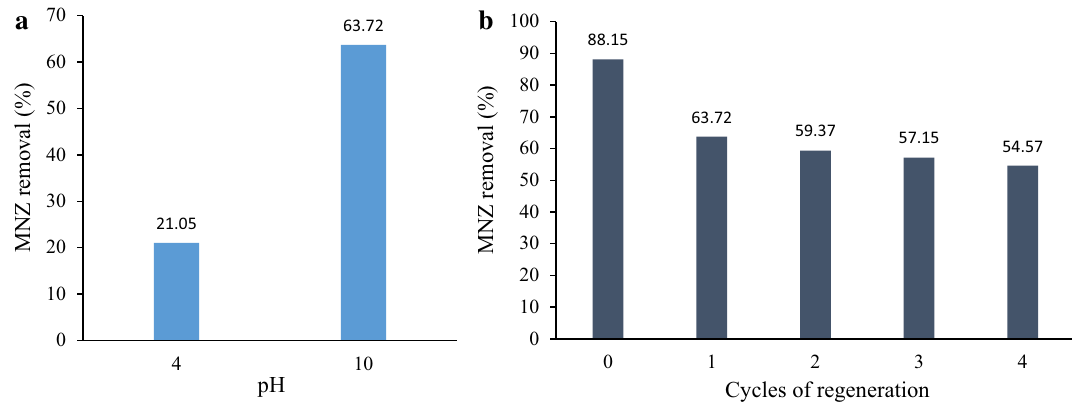
Fig. 6 Biomass reusability; MNZ removal efficiency for biomass regenerated by alkaline/acid eluting solution a and MNZ removal in consecu- tive adsorption/desorption cycles